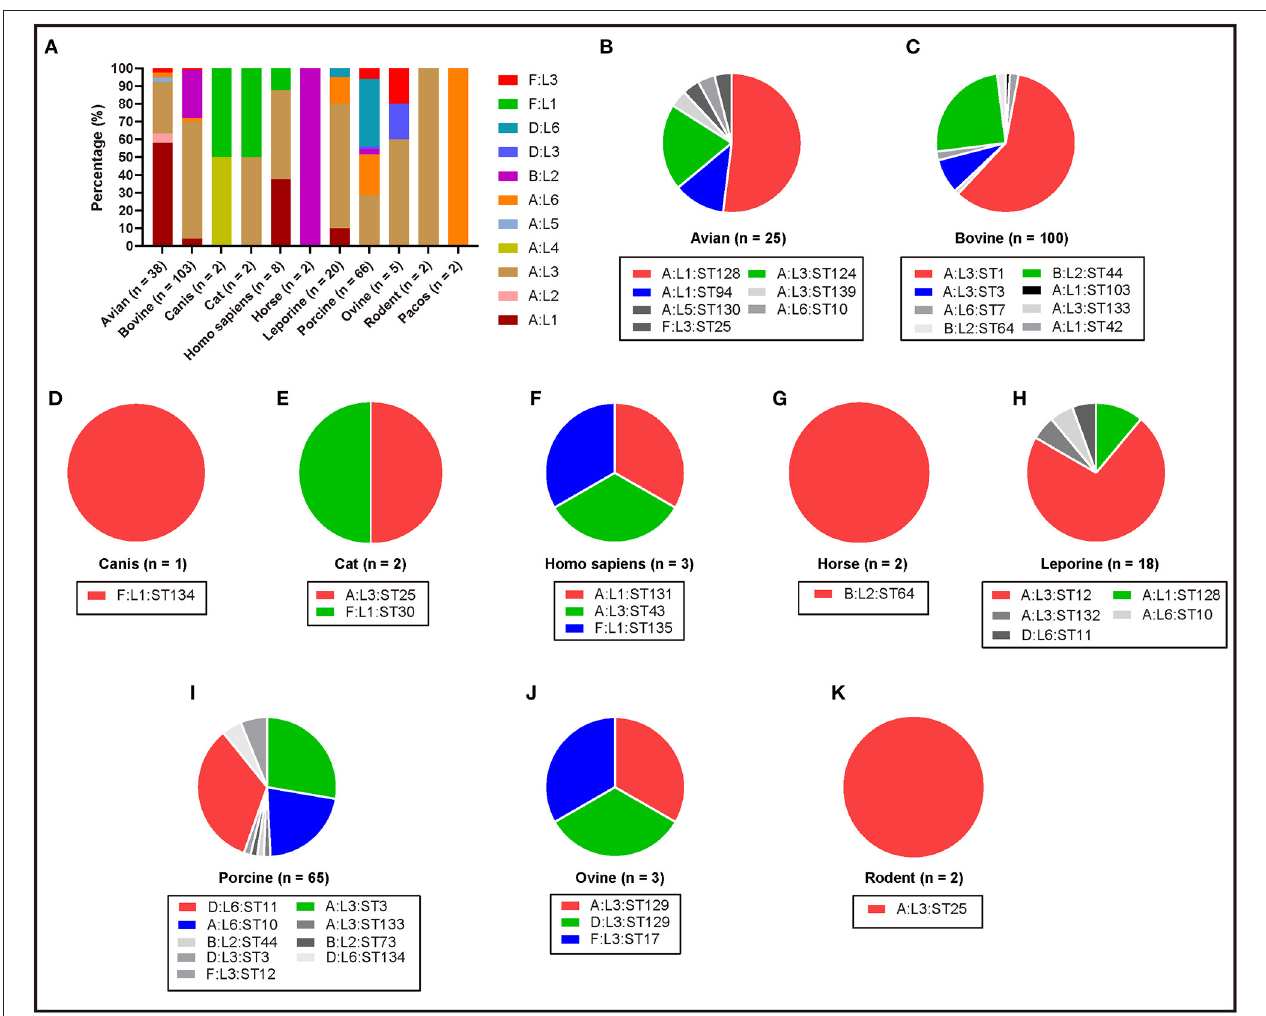
FIGURE 4 | Column and pie charts showing the distribution of capsular: LPS genotypes and/or the capsular: LPS: MLST genotypes of P. multocida strains from different host species determined by PmGT by using the whole genome sequences. (A) Column chart showing the distribution of capsular: LPS genotypes of P. multocida strains from different host species; (B–K) Pie charts showing the distribution of capsular: LPS: MLST genotypes of P. multocida strains from avian species, bovine species, canis, cats, humans, horses, leporine species, pigs, ovine species, and rodents,